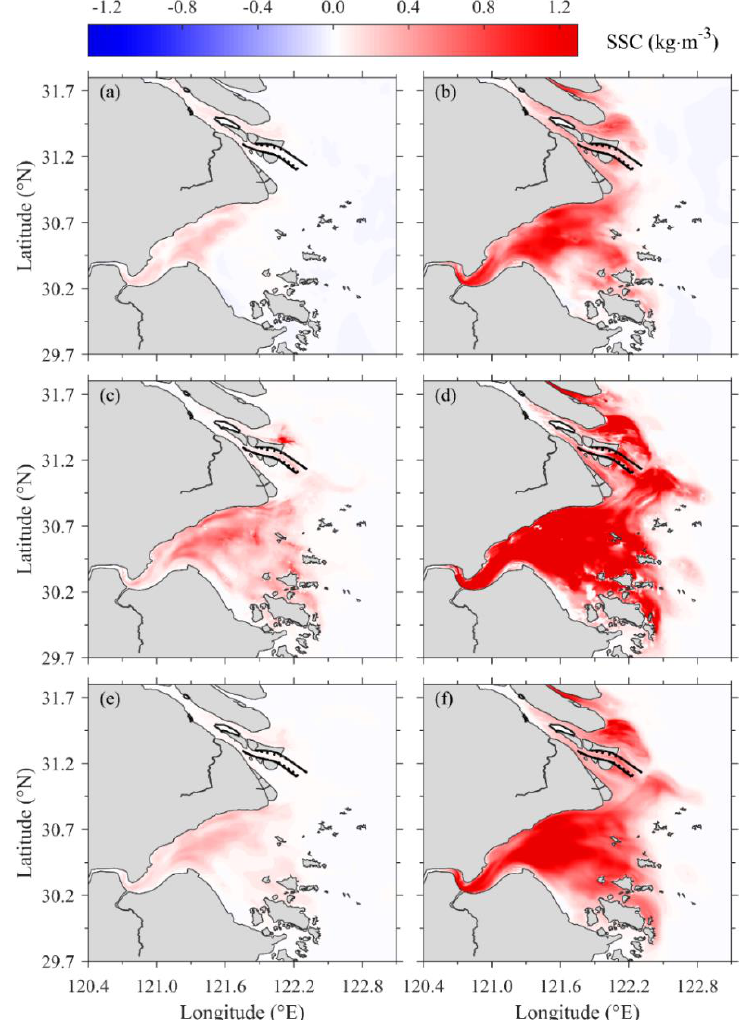
Figure 16. The SSC difference between Exp 1 and the control experiment in the surface layer (upper panel), bottom layer (middle panel), and whole layer (lower panel) during neap tide ( a , c , e ) and spring tide ( b , d , f ).